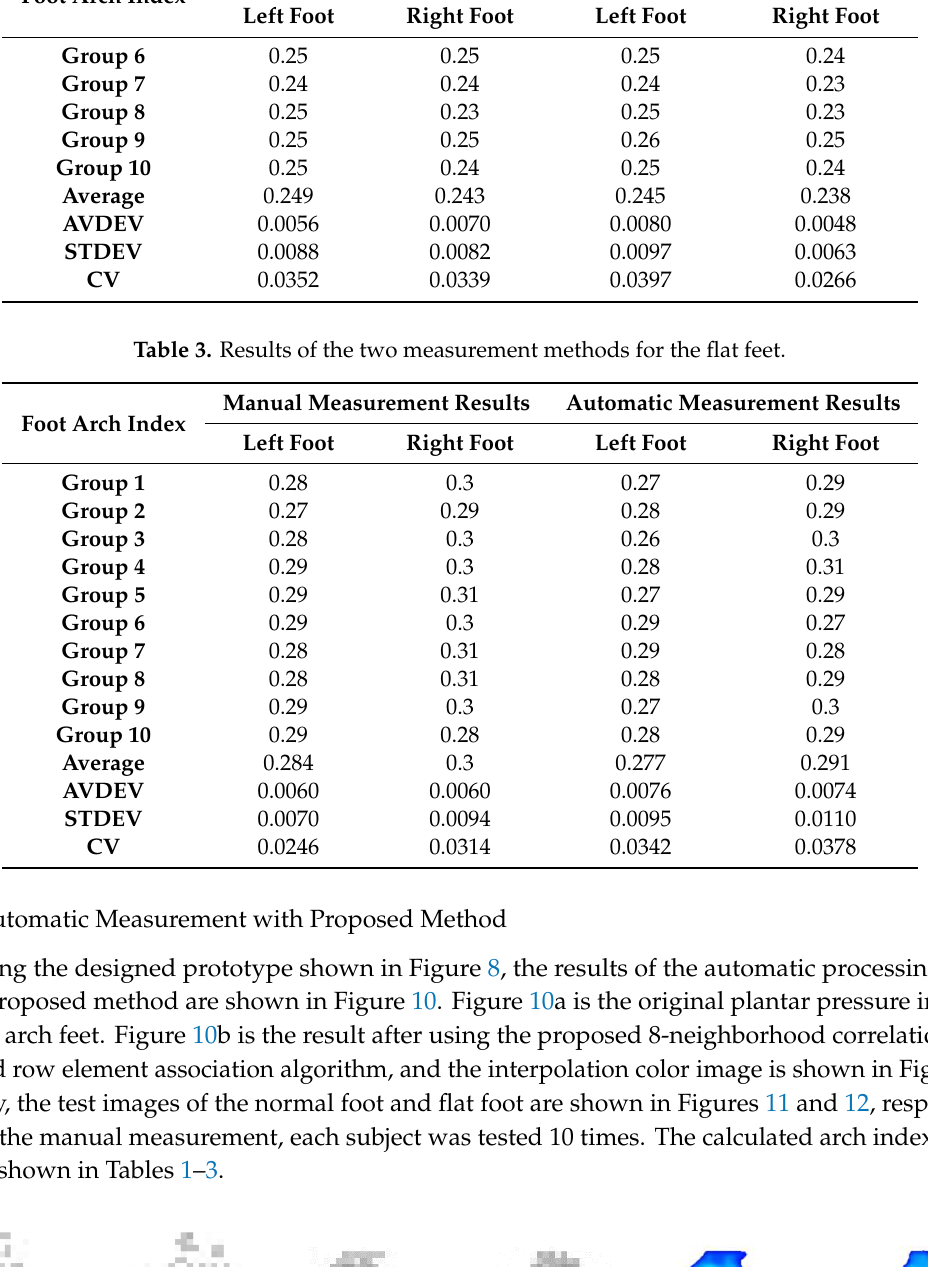
( c ) Figure 11. The results of automatic processing based on the proposed method for the normal feet. ( a ) is the original plantar pressure image of the normal feet, ( b ) is result after using the proposed method and ( c ) is the interpolation color image of ( b ). ( a ) ( c ) Figure 12. The results of automatic processing based on the proposed method for the flat feet. ( a ) is the original plantar pressure image of the flat feet, ( b ) is result after using the proposed method and ( c ) is the interpolation color image of ( b ). 4. Discussion The contrast experiment results are shown in the following tables. Within the error range allowed, both the results of the manual measurement and proposed automatic measurement methods have some fluctuations. In the manual measurement, the mean values for the high arch foot, normal foot and flat foot are 0.15, 0.18; 0.25, 0.25 and 0.28, 0.30, respectively. The mean values of the proposed automatic measurement results are 0.15, 0.17; 0.25, 0.24 and 0.28, 0.29, respectively.